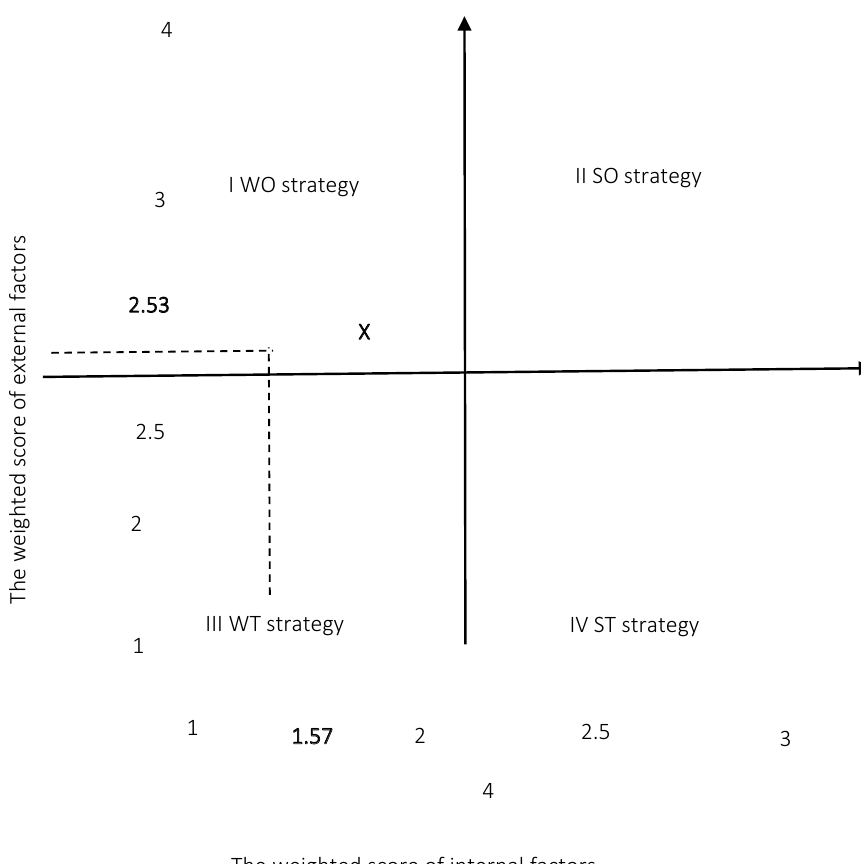
Figure 1. SPACE matrix of technology transfer to the agricultural sector of